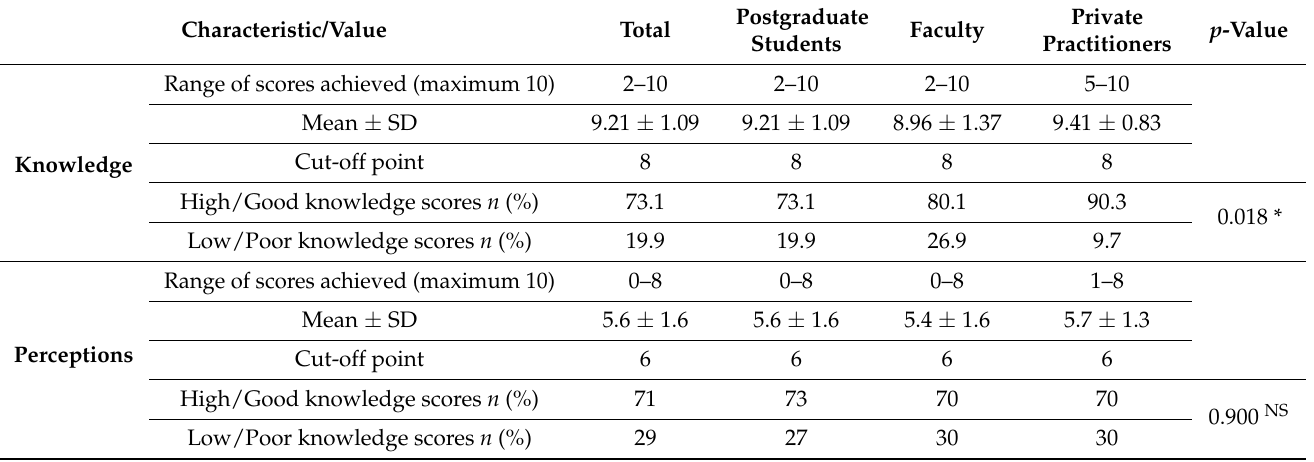
Table 3. Details of mean values of pediatric dentists based on